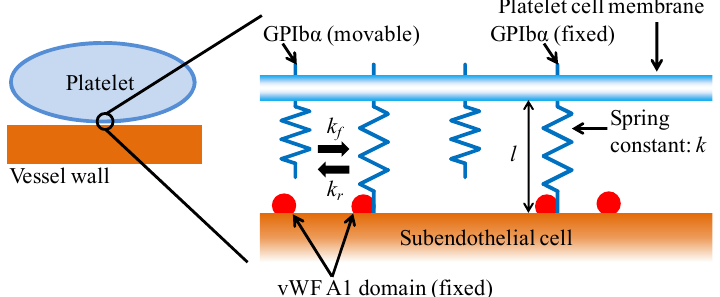
Schematic illustration of the platelet–vessel wall contact surface The kMC model was developed to evaluate the numbers of GPIb α –vWF bonds over time as well as the effect of GPIb α localization on the adhesion force between a platelet and vessel wall. A two-dimensional lattice with the periodic boundary condition was used to represent the platelet cell membrane and cell surface molecules. Fig. 2 is a schematic representation of the structure of the kMC lattice model. Simulations were performed on a 750 × 750 square lattice, with a lattice spacing of 2 nm that contained 4000 GPIb α . The GPIb α –vWF reaction areas were located around unbound vWFA1 domains with an area of 4 nm 2 , which corresponds to one lattice cell. The calculation area corresponds to approximately 20% of the surface area of a platelet. There are up to 3600 vWF subunits